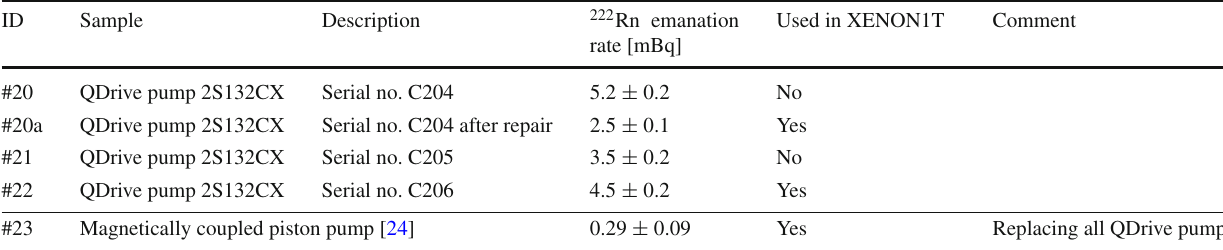
Table 4 222 Rn emanation measurements of xenon recirculation